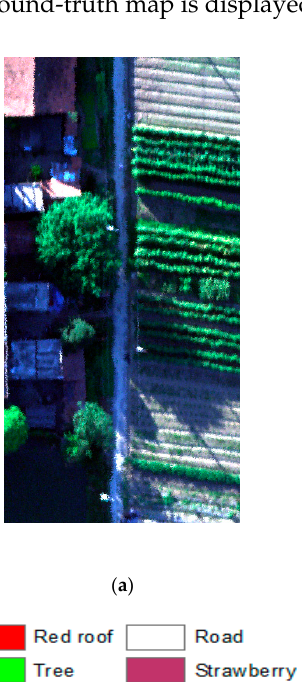
(b) Figure 7. The Honghu dataset: ( a ) The true-color image; ( b ) the ground-truth map. 3.3. Experimental Description